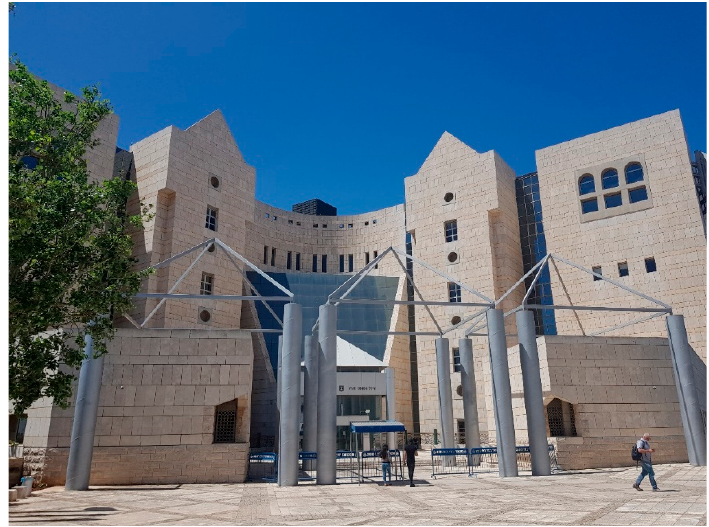
Figure 9. Overview of the building.